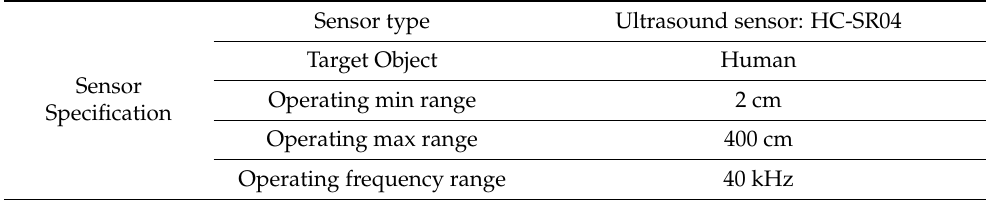
Table A2. The proposed indoor/ outdoor accuracy